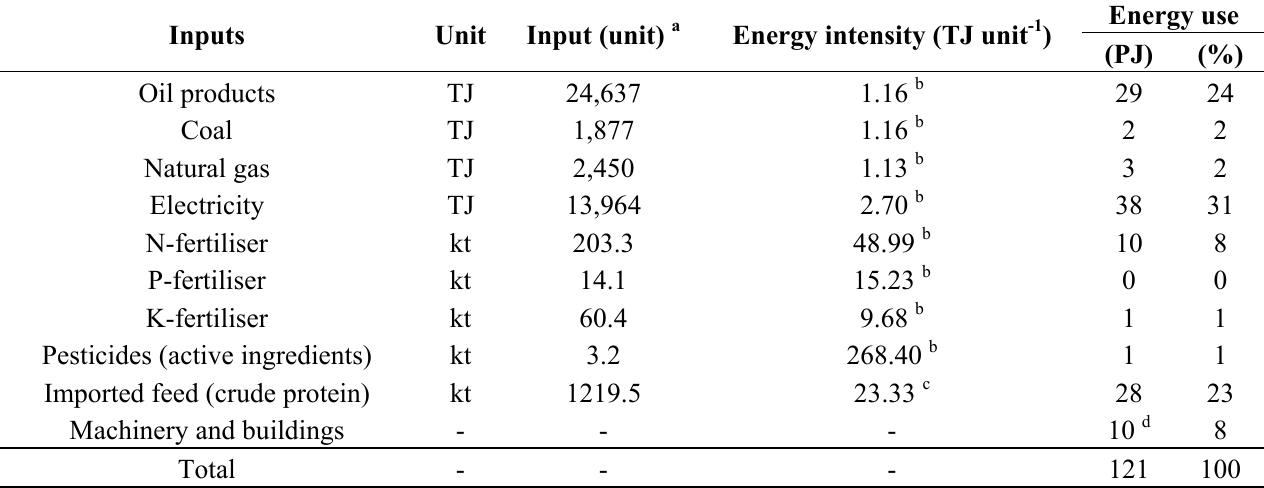
Table 2. Annual input to Danish agriculture and corresponding direct and indirect fossil energy use.